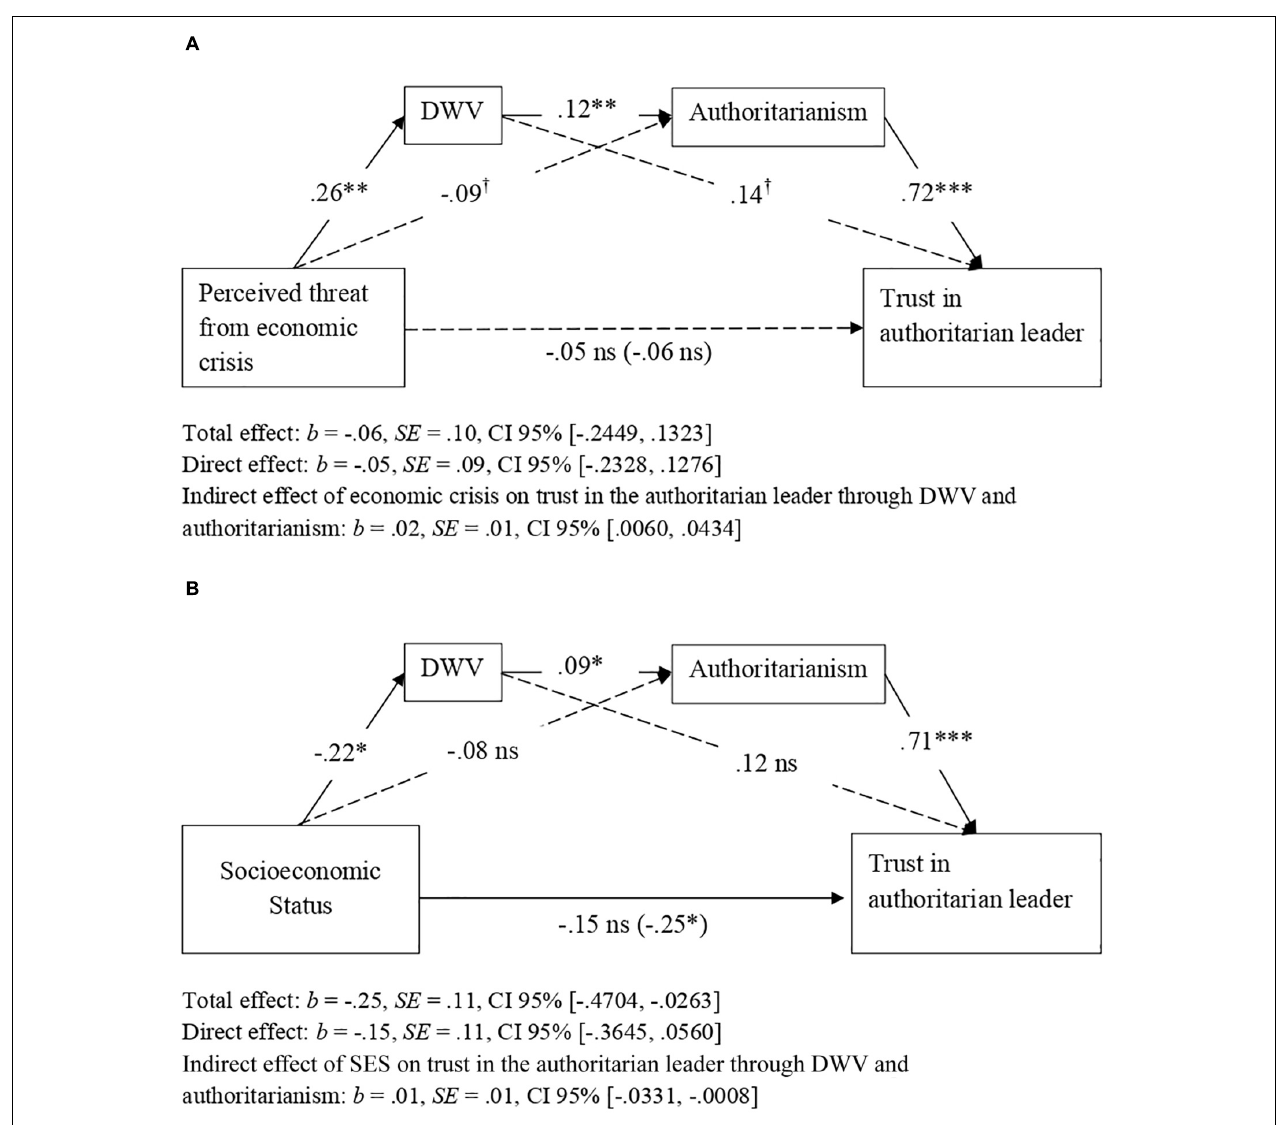
FIGURE 2 | Indirect effects of perceived threat form economic crisis (A) and SES (B) on trust in an authoritarian political leader via dangerous worldview (DWV) and authoritarianism (Study 1). Figure shows the effects without consideration of covariates. Non-significant effects appear with dashed lines. Unstandardized coefficients presented. * p < 0.05, ** p < 0.01, *** p < 0.001, † p <